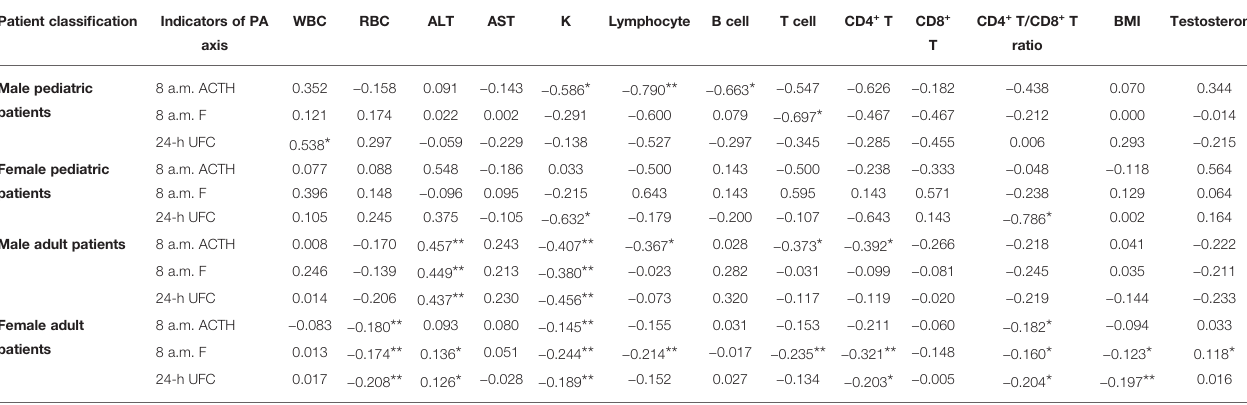
TABLE 4 | Correlation (r s ) between indicators of the PA axis and other laboratory investigation